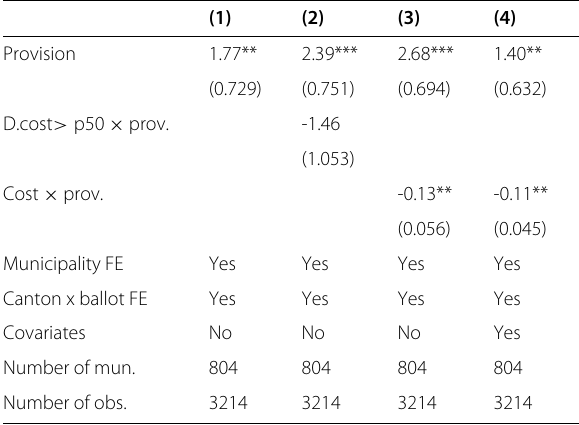
Table 2 DiD estimates for municipalities in the canton of Bern and control cantons, including per capita costs of institutions borne by the